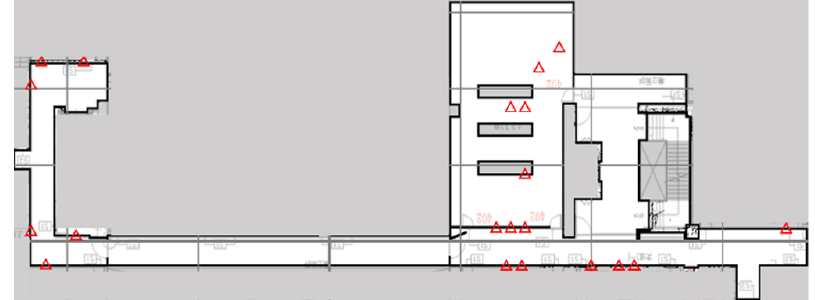
Figure 6. The optimal configuration Q using the GA with entropy (20 Wi-Fi Sniffers).